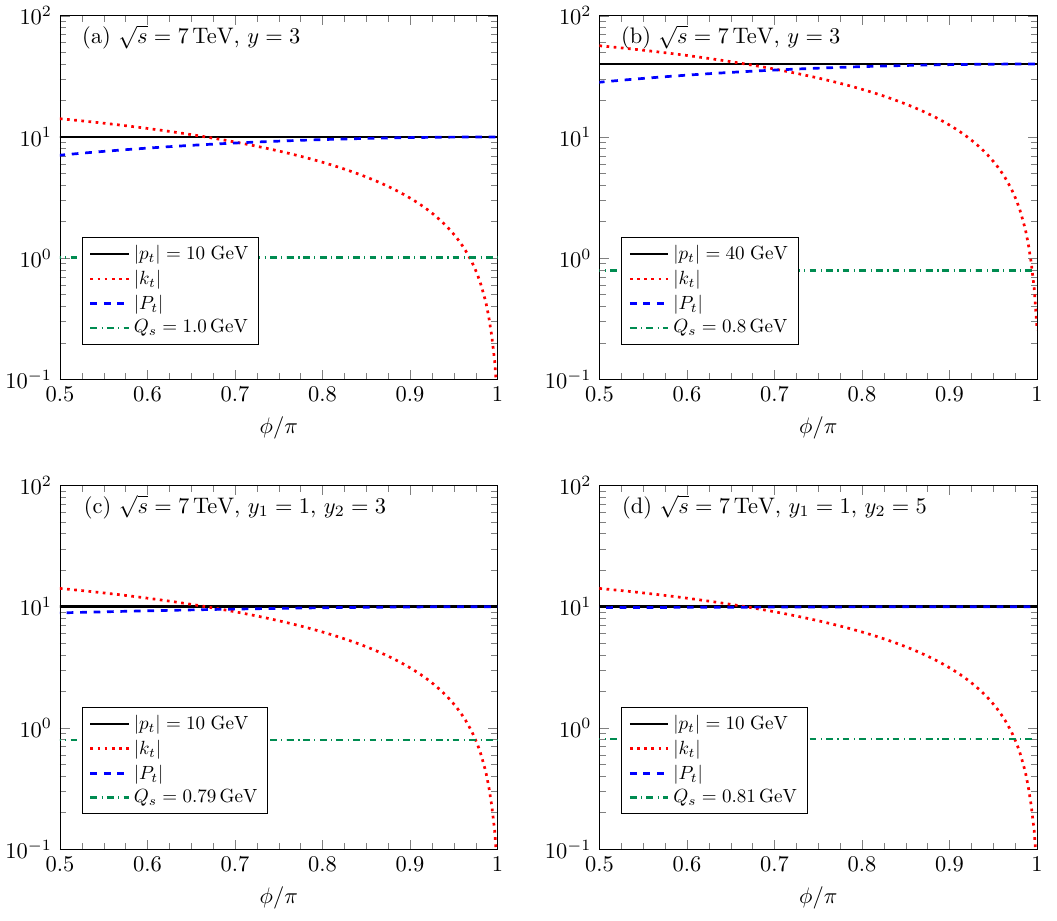
Figure 4 . Azimuthal angle dependence of | k t | (dotted) and | P t | (dashed) with (a): | p t | = 10 GeV and y 1 = y 2 = 3 , (b): | p t | = 40 GeV and y 1 = y 2 = 3 , (c): | p t | = 10 GeV and y 1 = 1 and y 2 = 3 , and (d): | p t | = 10 GeV and y 1 = 1 and y 2 = 5 . Saturation momentum Q s (dash-dotted) in each plot